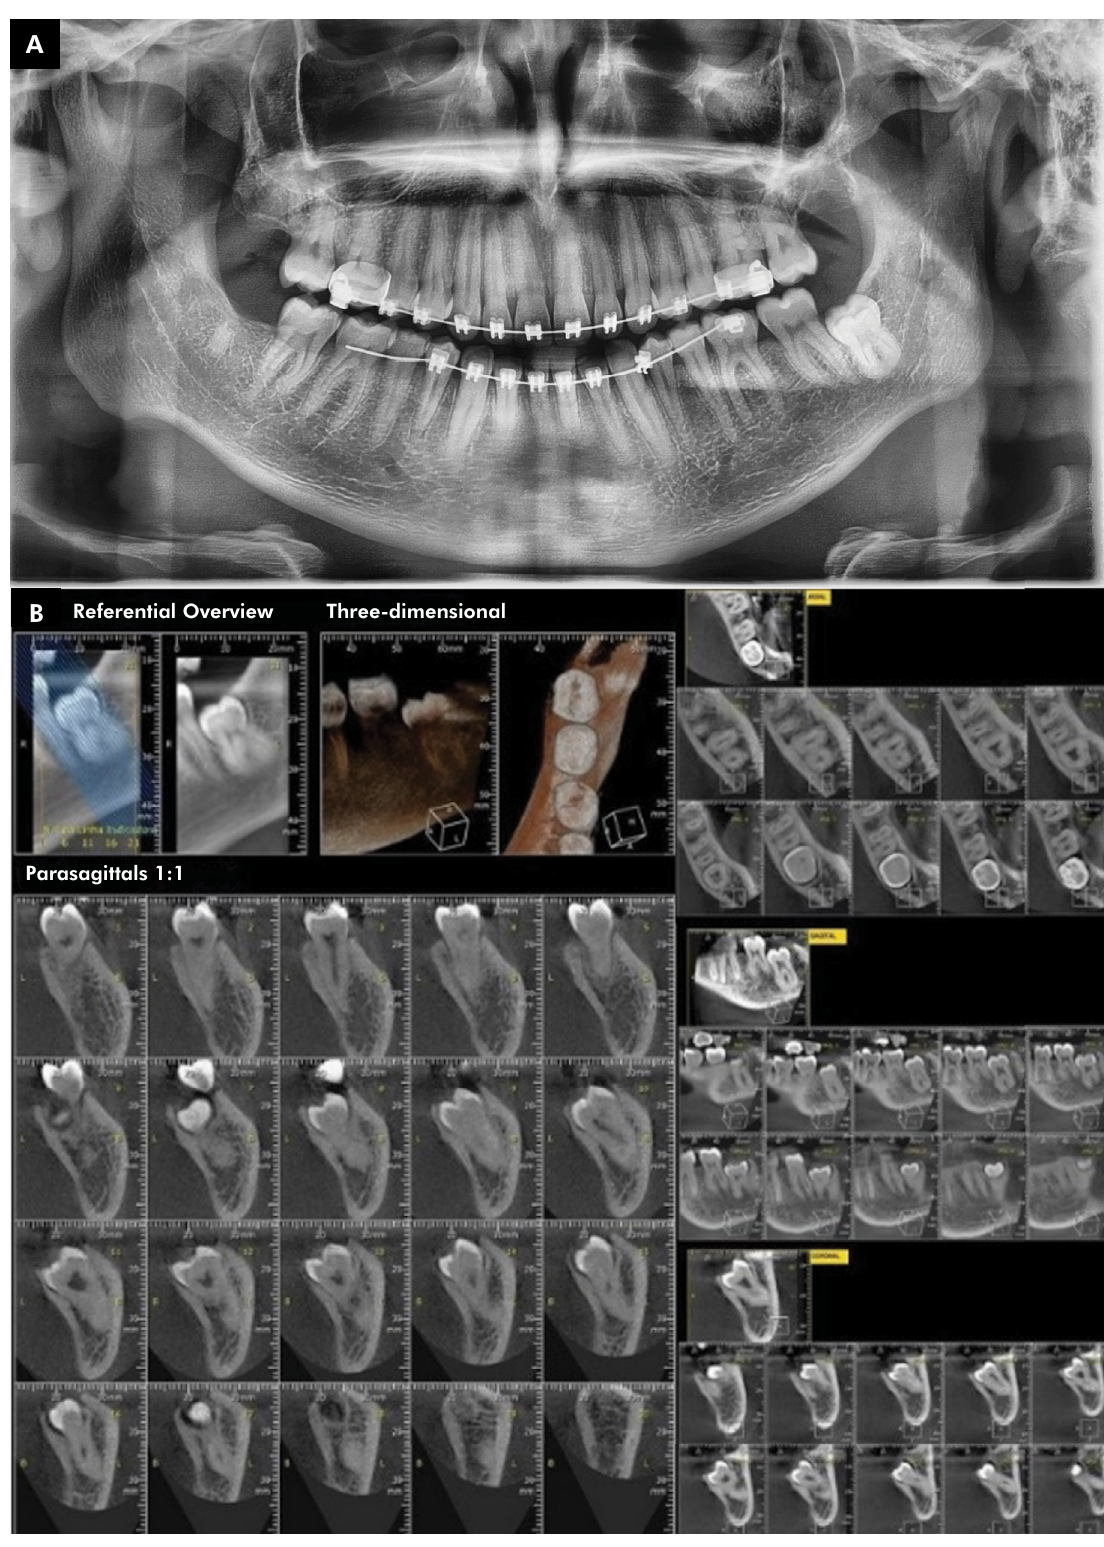
Figure. (A) panoramic radiograph from the first questionnaire and (B) multiplanar tomographic sections from the second questionnaire.